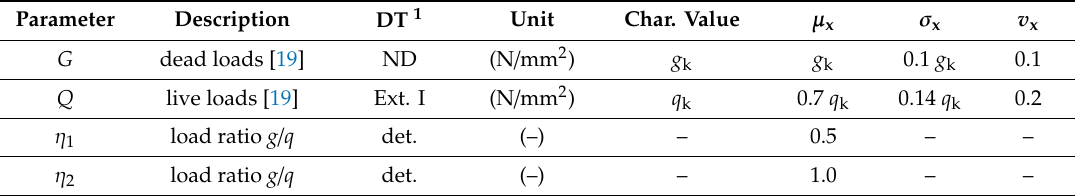
Table 2. Overview of the loads—statistical description of the applied loads [9].